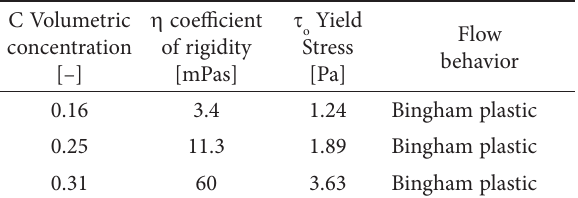
Table 5. Flow properties of Mátra Power Plant, Fly Ash from